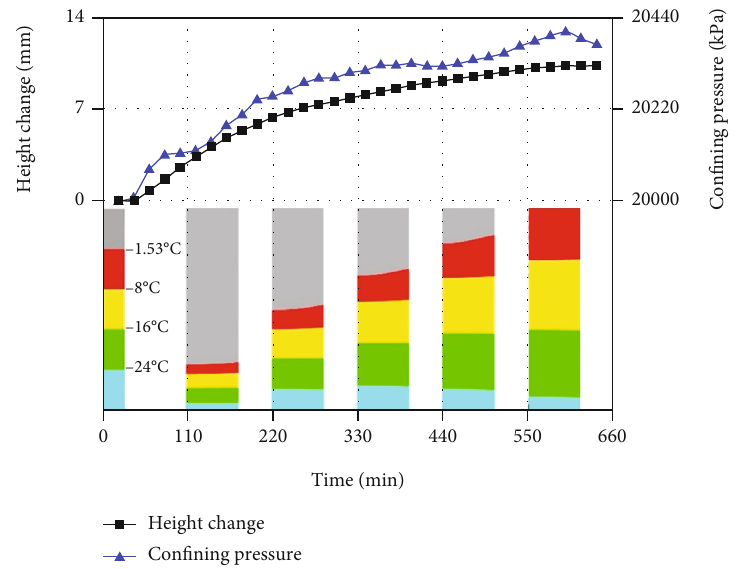
Figure 12: Changes in the simulated freezing state of the sample, the measured sample height, and the measured con fi ning pressure over time by the use of the freezing technique. The freezing state of the sample is shown through an axisymmetric plane, and the time corresponds to the symmetry axis (left border of the